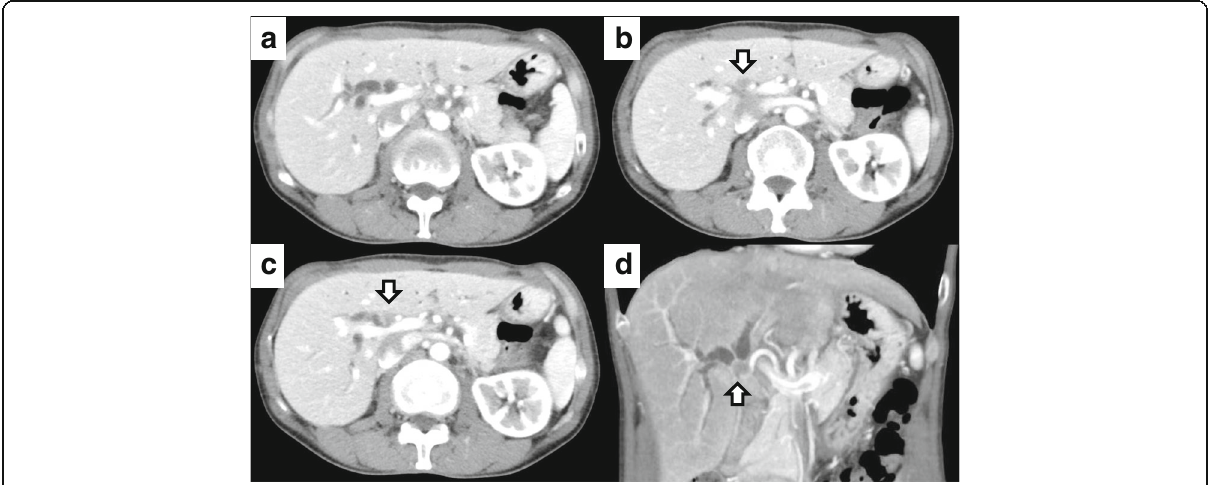
Fig. 1 Contrast-enhanced abdominal computed tomography (CT) findings. Contrast-enhanced CT showed an approximately 10-mm high-attenuation intraductal mass at the hepatic hilum (arrow) and dilation of the intrahepatic bile duct. a – c Axial views. d Coronal